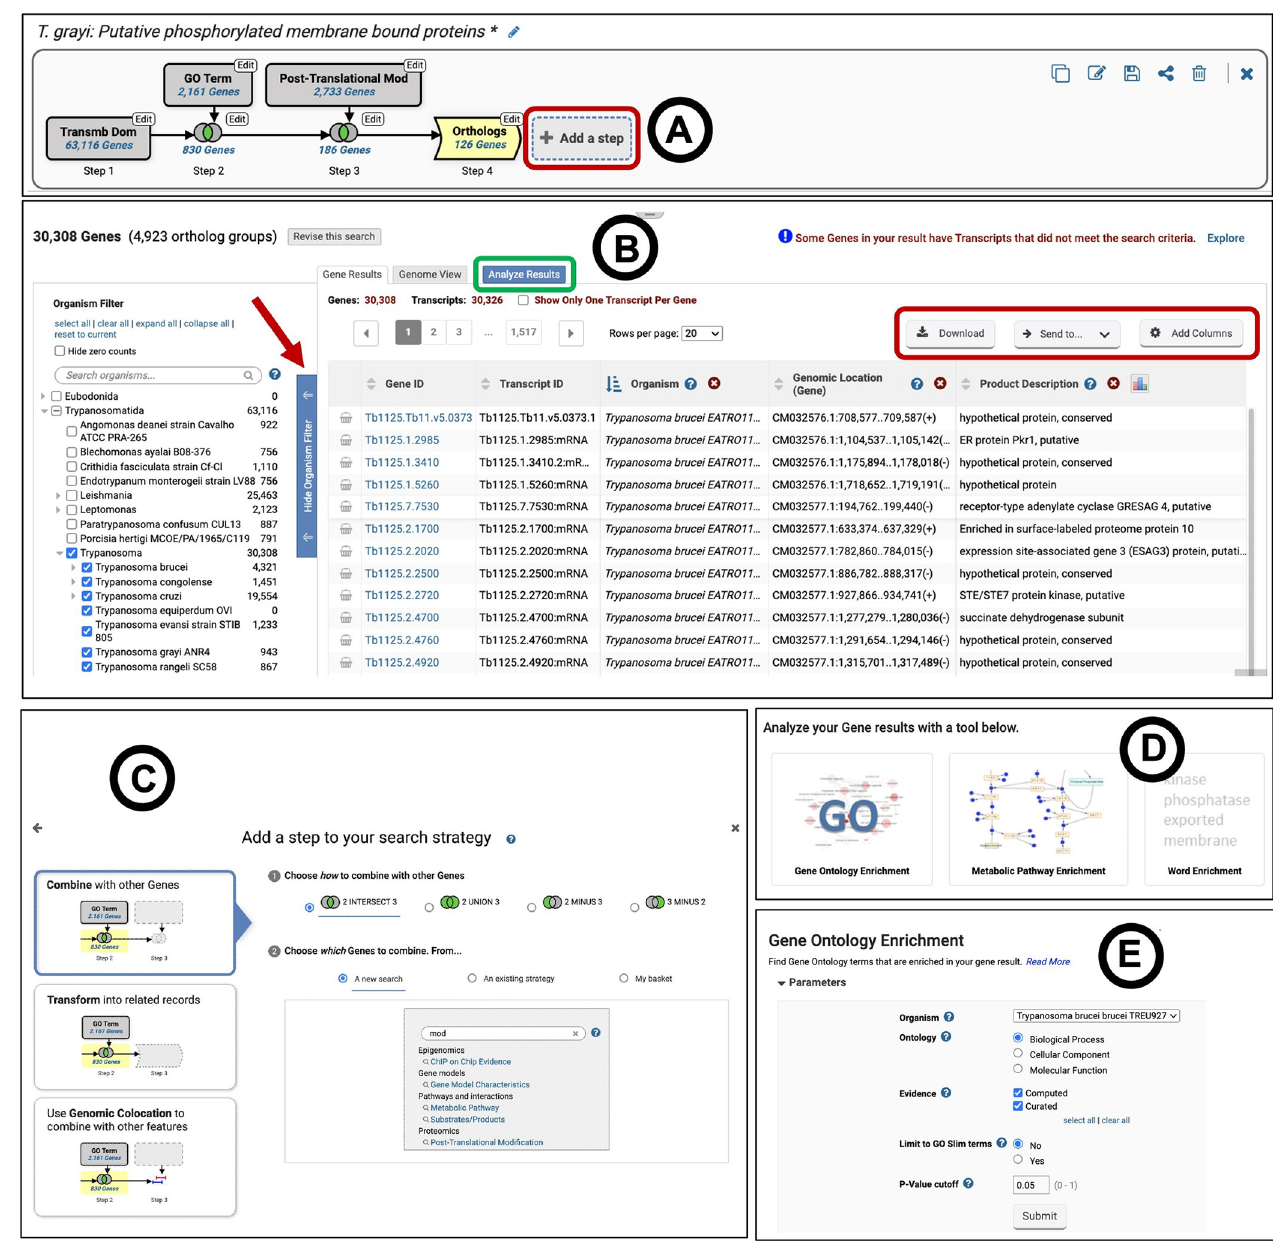
Fig 2. Search strategies as in silico experiments and functional enrichment analysis. (A) The graphic panel shows an example multi-step search strategy (https://tritrypdb.org/tritrypdb/app/workspace/strategies/import/9c17640460e66cd5). (B) Results of the first step of the search strategy, with the redesigned vertical organism filter on the left (red arrow) and the results table on right. (C) Redesigned ‘Add Step’ popup showing the three options to add steps, ‘Combine’, ‘Transform’ and ‘Genomic Colocation’, and the details of the chosen option. (D) The three options available for the analysis of gene results: GO enrichment, metabolic pathway enrichment and word cloud. (E) The form for selecting appropriate parameters for GO enrichment analysis.